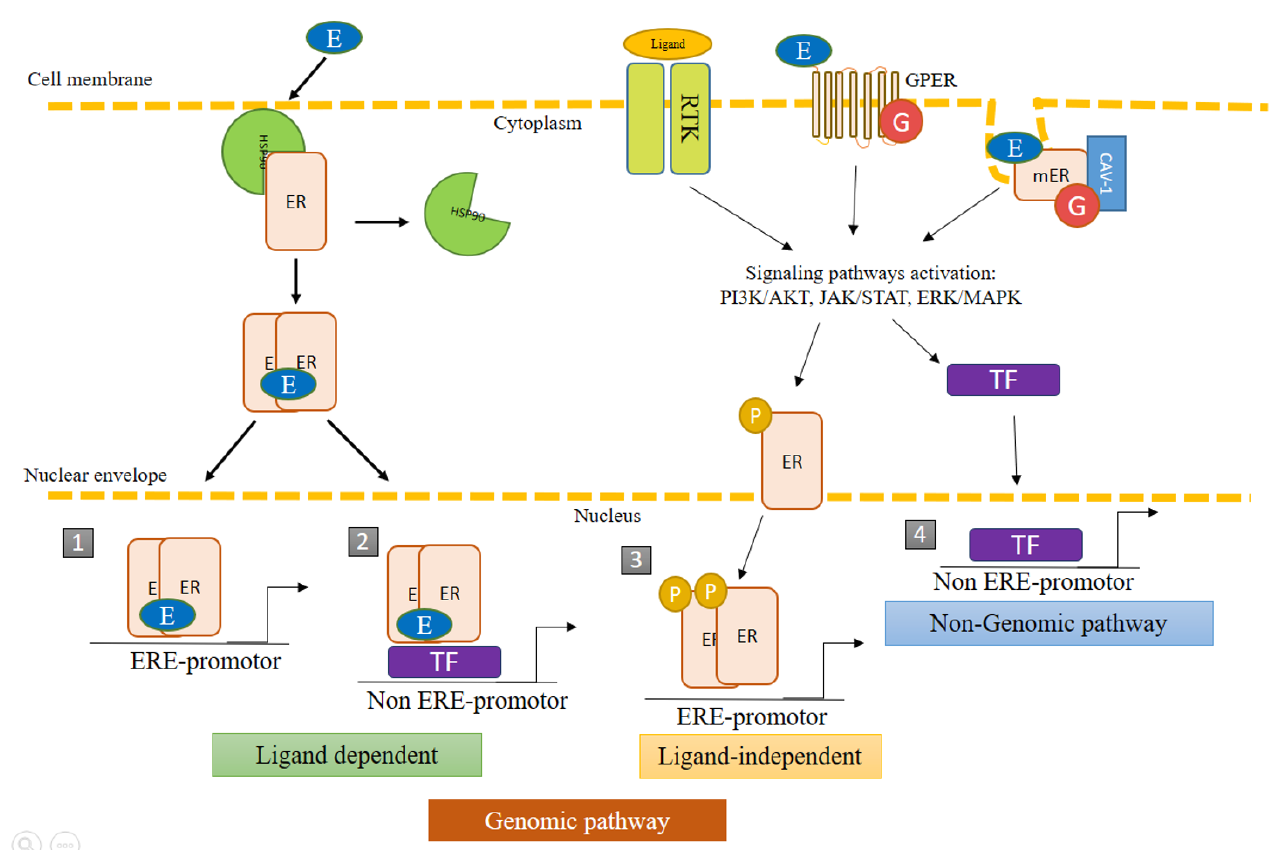
Figure 2. Genomic and non-genomic pathways of estrogen receptors (ERs). ERs can act through genomic pathways and nongenomic pathways. The nongenomic pathways may also result in the transcriptional activation of genes. (1) Classic pathway : dimerization of ERs triggered by the binding of E2, followed by nuclear translocation to regulate the transcriptional activity of genes bearing the estrogen response element (ERE). (2) ER activity independent of ERE : the recognition of promoters result from the protein − protein interaction of ERs with other transcription factors (TF). (3) Ligand-independent activity : the binding of growth factors to membrane receptors triggers protein kinase cascades that activate ERs by phosphorylation, promoting their nuclear translocation and recognition of the ERE in target genes. (4) Nongenomic pathway : the binding of the ligand causes mER and GPER1 to initiate signaling pathways, which promote the activation of enzymes and transcriptional factors that can regulate the transcription of diverse genes. ER, estrogen receptors; mER, membrane estrogen receptors; TF, transcription factor; ERE, estrogen response element; non-ERE, other transcription factors distinct from ERE; P, phosphorylated receptor; G, G protein-coupled receptor; GPER, G protein-coupled estrogen receptor; cav, caveolin.